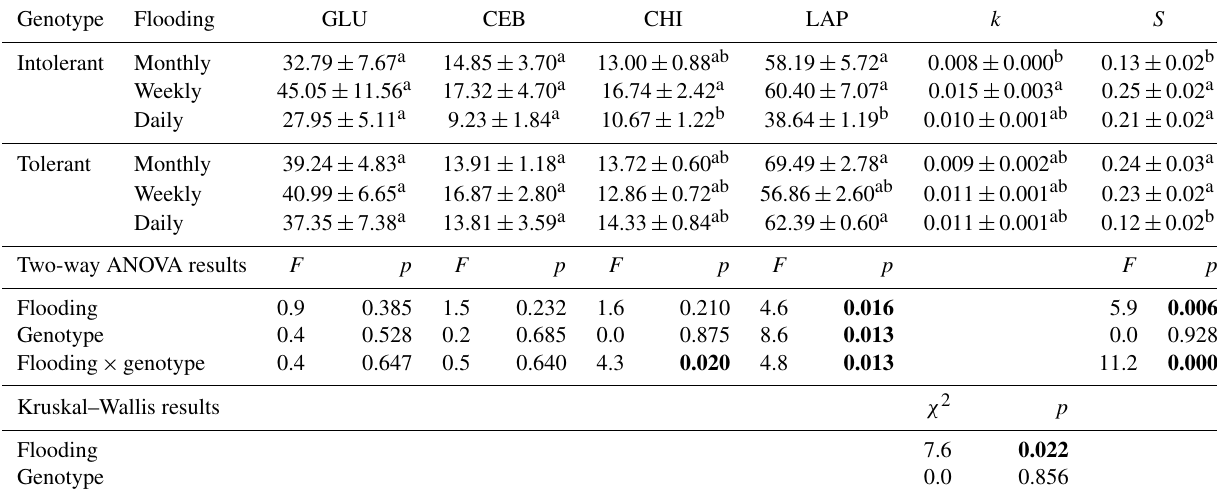
Table 1. Exo-enzyme activities (nmolgDW − 1 h − 1 ) of ß-glucosidase (GLU), cellobiosidase (CEB), chitinase (CHI), and leucine- aminopeptidase (LAP) as well as the litter-breakdown parameters k (decomposition rate constant) and S (stabilization factor) in soils planted with intolerant and tolerant plant genotypes of Elymus athericus exposed to three different flooding frequencies (monthly, weekly, and daily). Values are means and SE ( n = 8). Values not connected by the same letter within one column are significantly different at p ≤ 0 . 05 based on Tukey’s HSD tests. Corresponding two-way ANOVA results are included below ( p values highlighted in bold at p ≤ 0 . 05). Nonparametric Kruskal–Wallis tests were conducted instead of ANOVA and Tukey’s tests for k